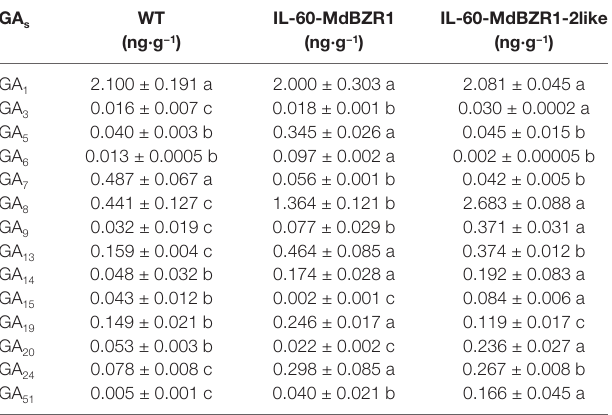
TABle 2 | GA contents in Il60- MdBZR1 and IL60- MdBZR1-2like apple